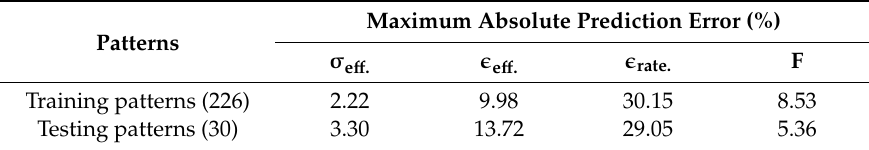
Table 3. Maximum percentage absolute prediction error.